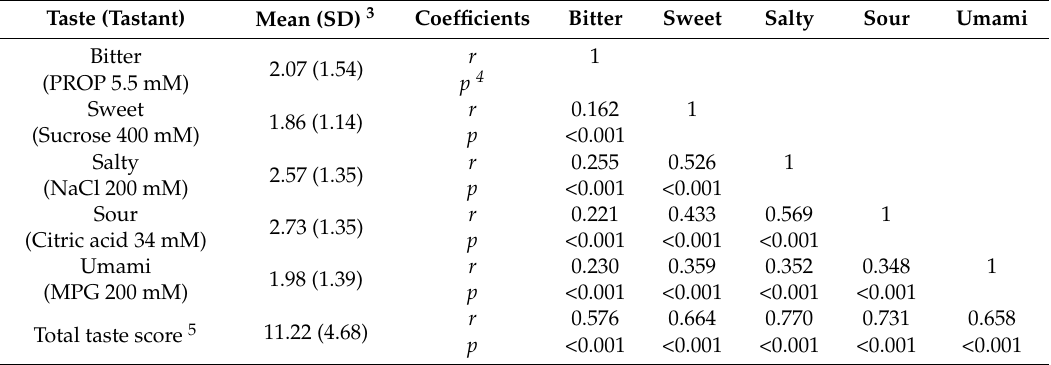
Table 2. Association between the perception of different tastants 1 and the total taste score in the whole population 2 .